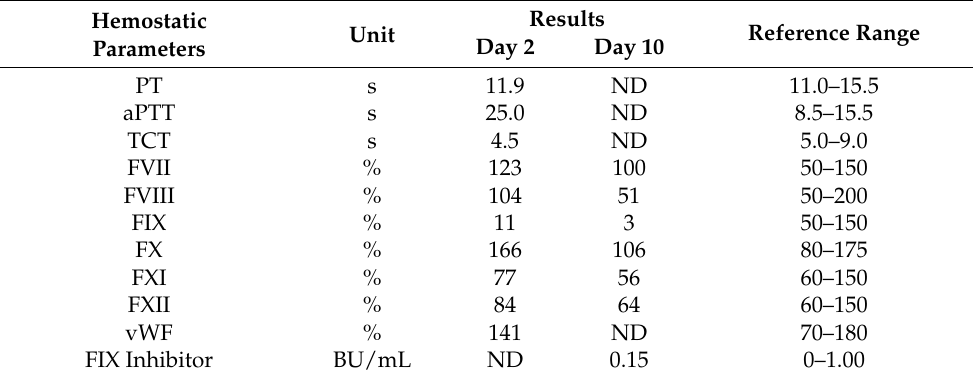
Table 2. Plasma hemostasis panel test results for a bleeding male Newfoundland–Parti Standard Poodle hybrid puppy with hemophilia B: Case #1.